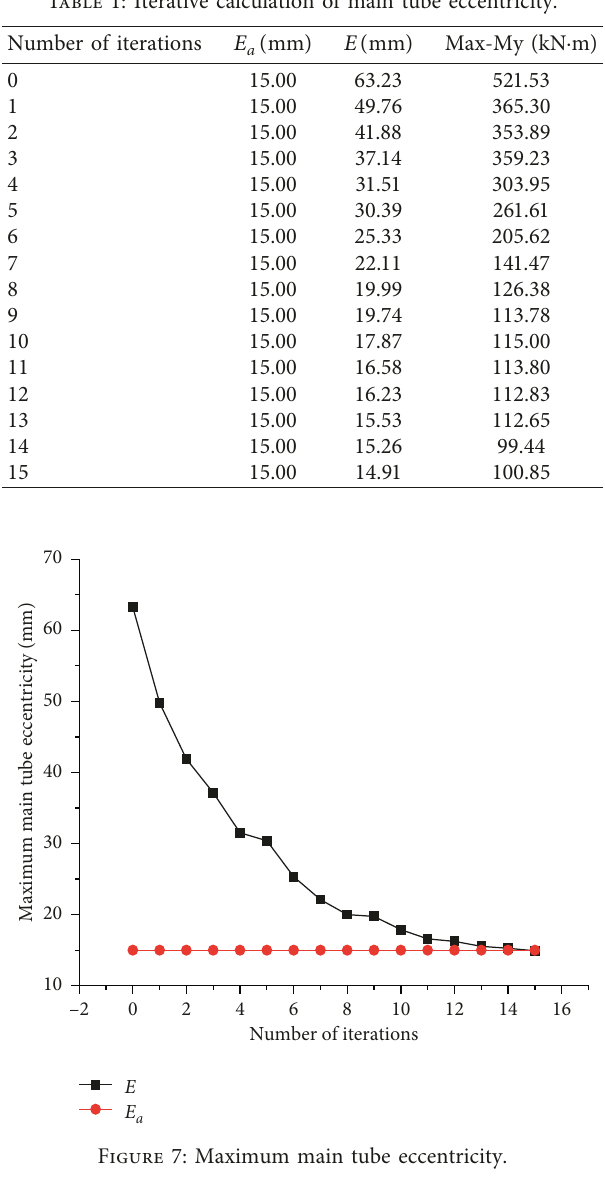
Figure 6: Bosideng Yangtze River Bridge and its elements. Table 1: Iterative calculation of main tube eccentricity.